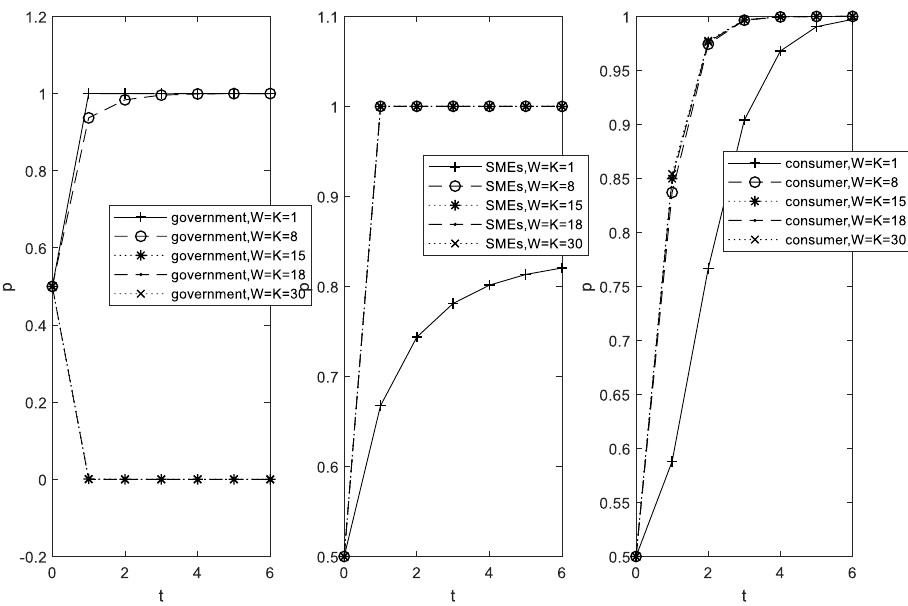
Figure 12. Evolution of different dynamic strategy policy criteria.